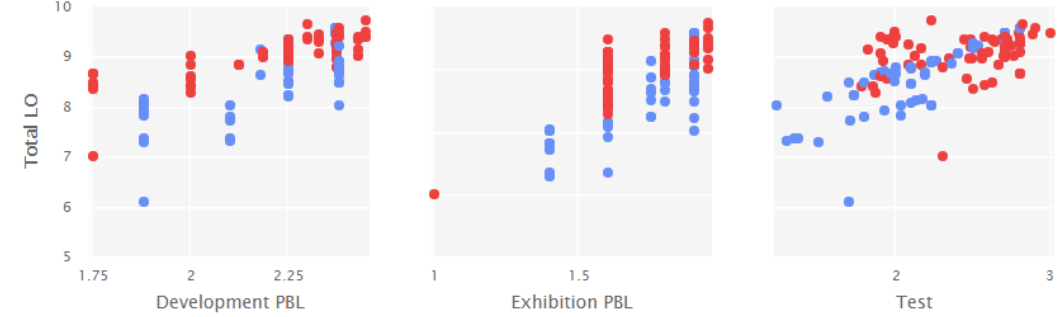
Figure 1. Distribution of scores in the di ff erent types of Learning outcomes. Note. Development PBL = Development Project-Based Learning outcomes; Exhibition PBL = Exhibition Project-Based Learning outcomes; Test = Test Learning outcomes; Total LO = Learning outcomes Total.